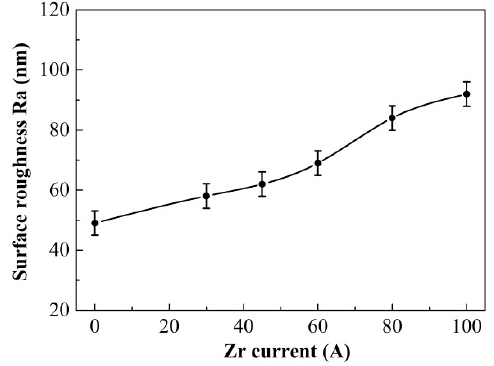
Figure 4. Surface roughness of the composite coatings.